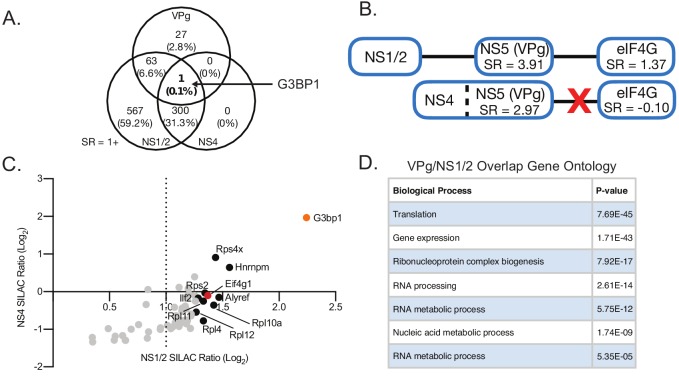
Further analysis of proteins enriched through MNV VPg proteomics and FLAG-tagged virus replication complex proteome data (Log2 SILAC ratio >1).(A) Venn diagram illustrating the degree of overlap between the proteins identified in the three proteomics approaches. The greatest overlap between VPg and the replication complex proteome data was observed between VPg and NS1/2. G3BP1 was enriched in pulldowns of all three bait proteins (VPg, NS1/2 and NS4). (B) The baits NS1/2 and NS4 both enriched VPg during replication complex pulldowns, but NS1/2 also enriched the VPg binding partner eIF4G, while NS4 did not. Immunoblot analysis revealed that NS4 enriched primarily the NS4/5 (VPg) polyprotein precursor, and not mature VPg, while NS1/2 enriched primarily the mature form of VPg (Figure 2C). (C) Plot of all MNV VPg binding partners identified in Figure 1 which overlapped with proteins associated with the replication complex through NS1/2 and NS4 purification. Most VPg interaction partners were better enriched by NS1/2 than NS4, except G3BP1. (D) Table showing Gene Ontology analysis of proteins enriched by VPg and NS1/2 during infection using PANTHER overrepresentation analysis, revealing a subset of the replication complex dedicated to translation and RNA metabolism.